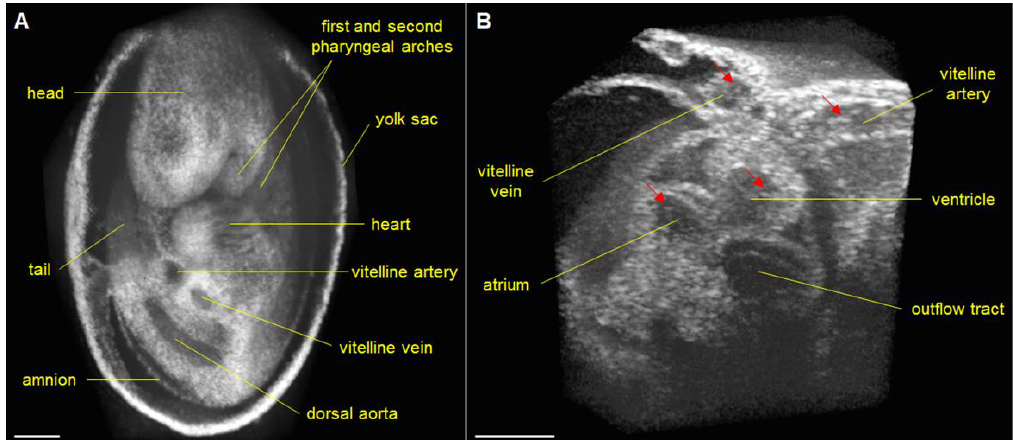
Figure 4. Direct 4-D embryonic imaging with 1.5 MHz OCT. ( A ) Large-field 3D OCT image of E9.5 mouse embryo obtained with slow galvanometer mirror scanning. ( B ) 4-D cardiodynamics of E9.5 mouse embryo obtained from direct time-lapse 3D imaging with a volume acquisition rate of ~43 Hz. Arrows indicate the blood cells. Scale bars are 300 μ m. Reproduced with permission from [49].